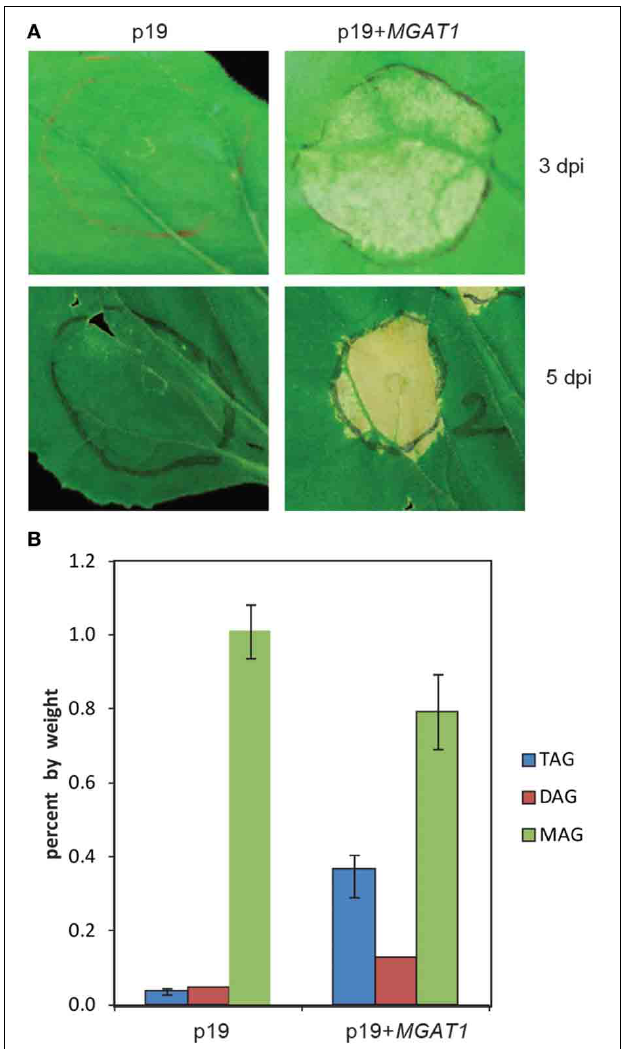
FIGURE 1 | Physiological and biochemical responses of monoacylglycerol acyltransferase ( MGAT1 ) transient expression in Nicotiana benthamiana leaves. (A) Senescence symptoms observed in leaf tissue infiltrated with MGAT1 at 3 days post-infiltration (dpi) and 5dpi. Infiltrations were performed along with p19 viral suppressor protein as control (Petrie et al., 2012). (B) Lipid analysis showing monoacylglycerol (MAG), diacylglycerol (DAG) and triacylglycerol (TAG) levels in p19 and p19 + MGAT1 infiltrated leaf spots, harvested at 2dpi. Data shown are average of three replicates and error bars represent standard error.